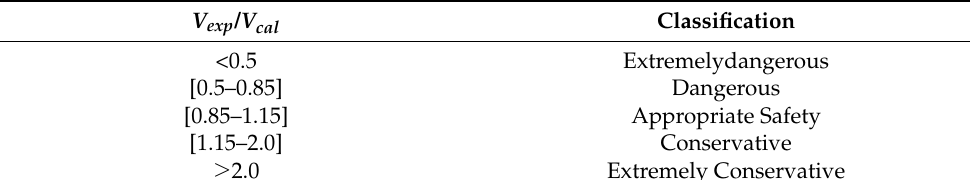
Table 6. The criteria for assessment of experimentally fixed ( V exp ) and computational ( V cal ) shear capacity values [76].